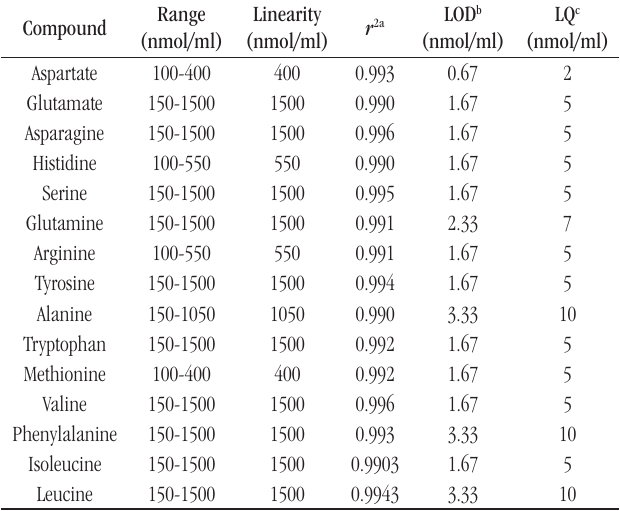
taBLE 3 − Linearity, limit of detection and quantification of the method